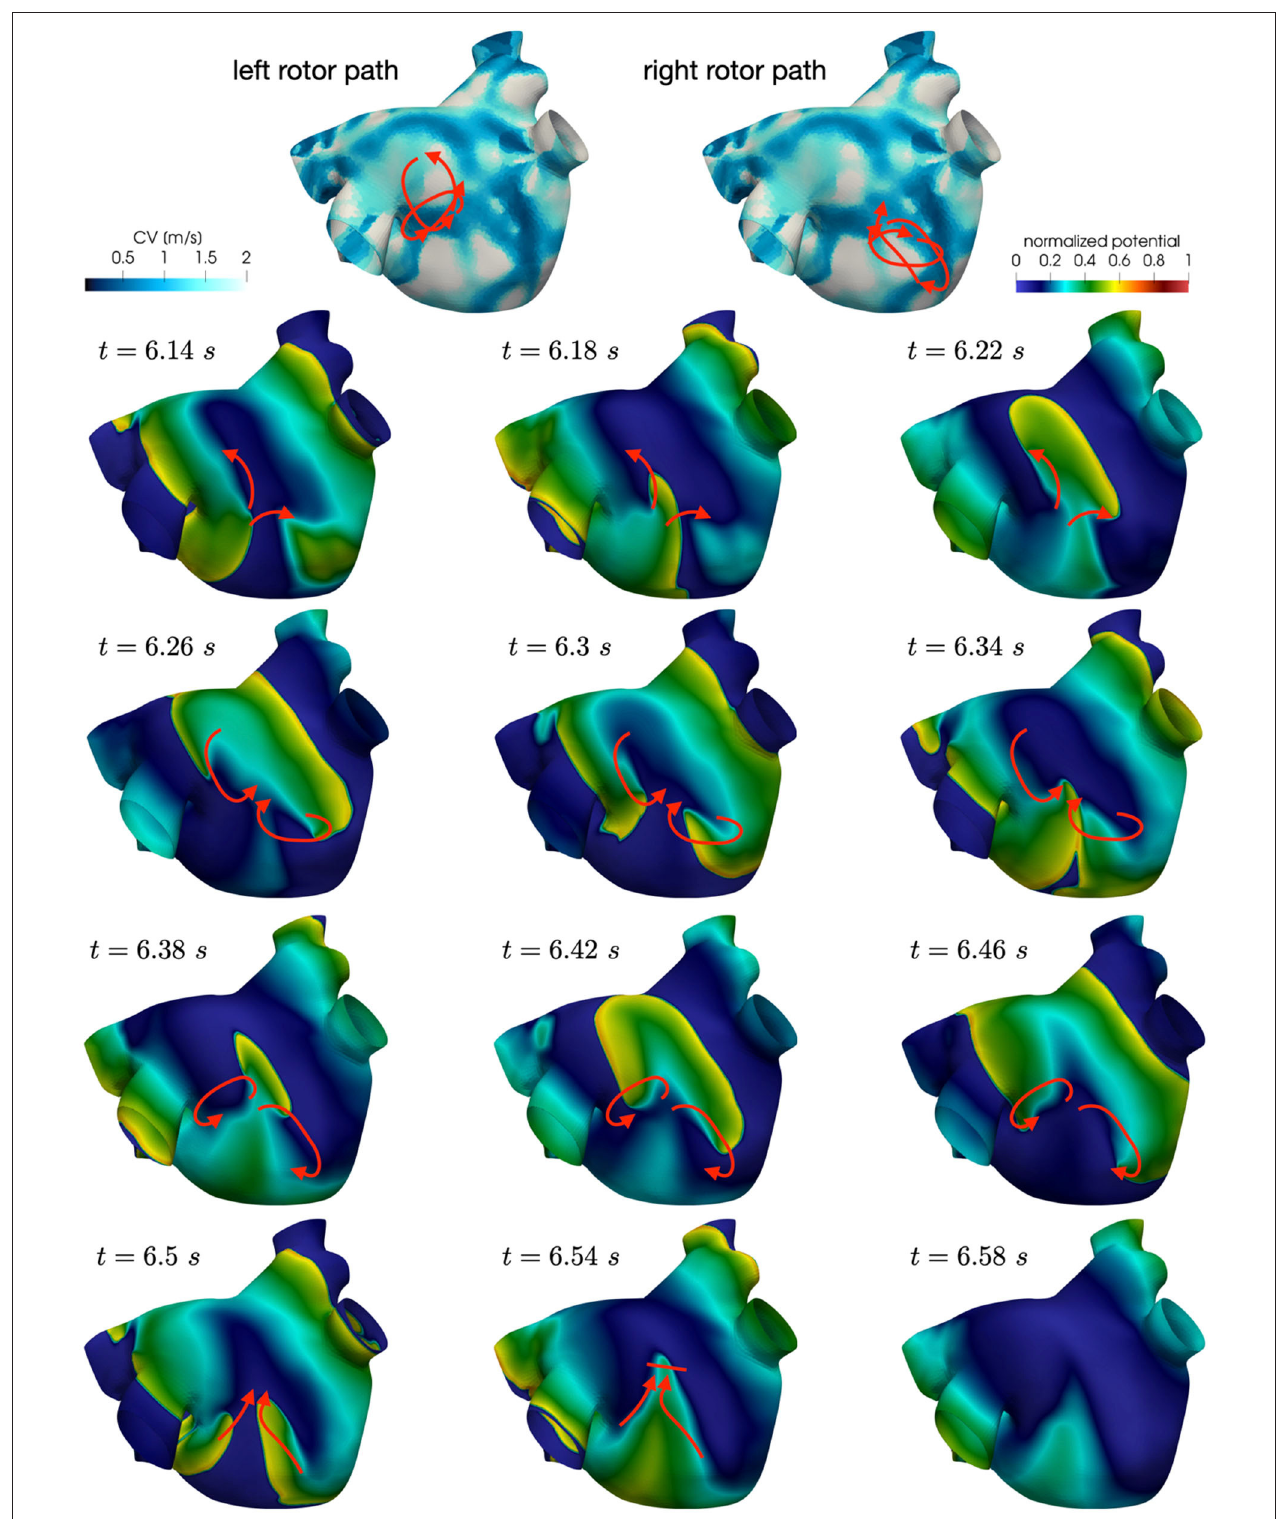
FIGURE 14 | Rotors position in unstable localized reentry in paroxysmal AF. The reentry is interrupted by head-tail interaction.